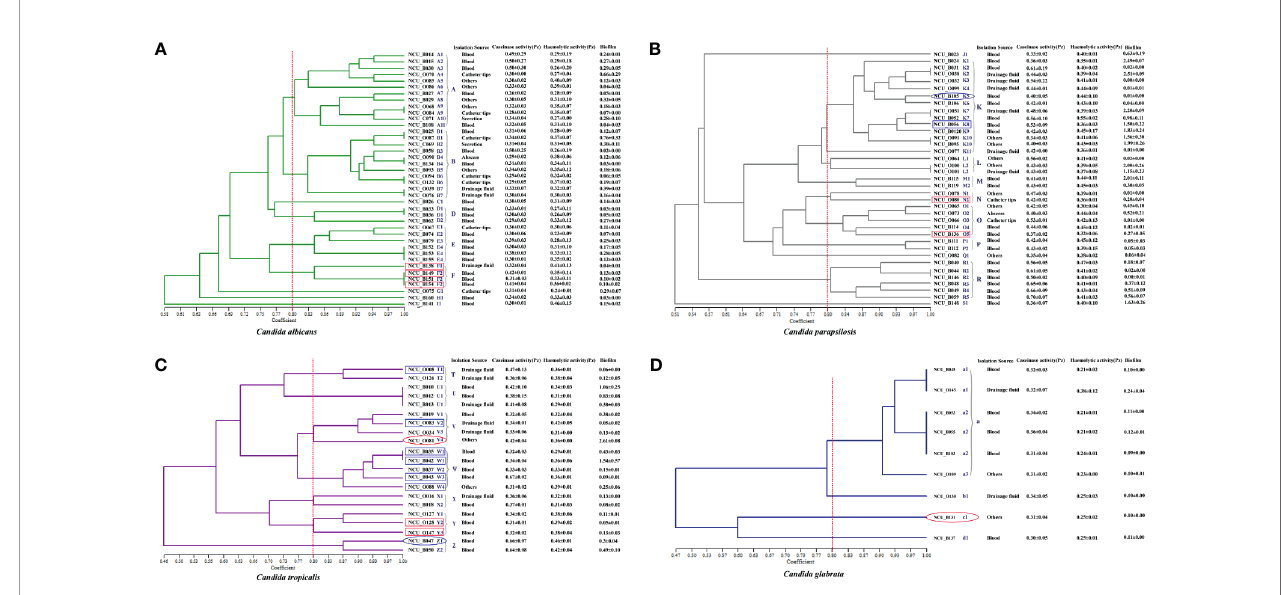
FIGURE 2 | Dendrogram presenting the genetic relatedness of 107 Candida spp. based on the random ampli fi ed polymorphic DNA (RAPD) data. The virulence factors (i.e., caseinase, hemolysin, and bio fi lm), drug resistance, and specimen sources are indicated in the fi gure. The vertical line divides the strains based on the level of genetic similarity into related and unrelated strains. The red boxes indicate azole resistance ( fl uconazole and voriconazole), whereas the blue boxes indicate azole-susceptible (S) dose dependence (SDD). Red ellipses represent resistance to echinocandins, while the blue ellipses represent intermediate resistance to micafungin. (A) Dendrogram of 40 C. albicans isolates. (B) Dendrogram of 37 C. parapsilosis isolates. (C) Dendrogram of 21 C. tropicalis isolates. (D) Dendrogram of 9 C. glabrata